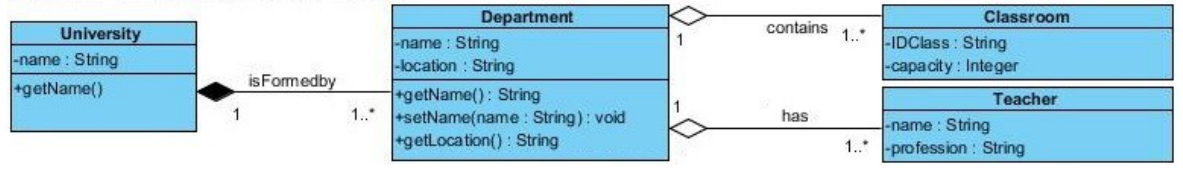
Figure 17 . UML class diagram of the demonstration case